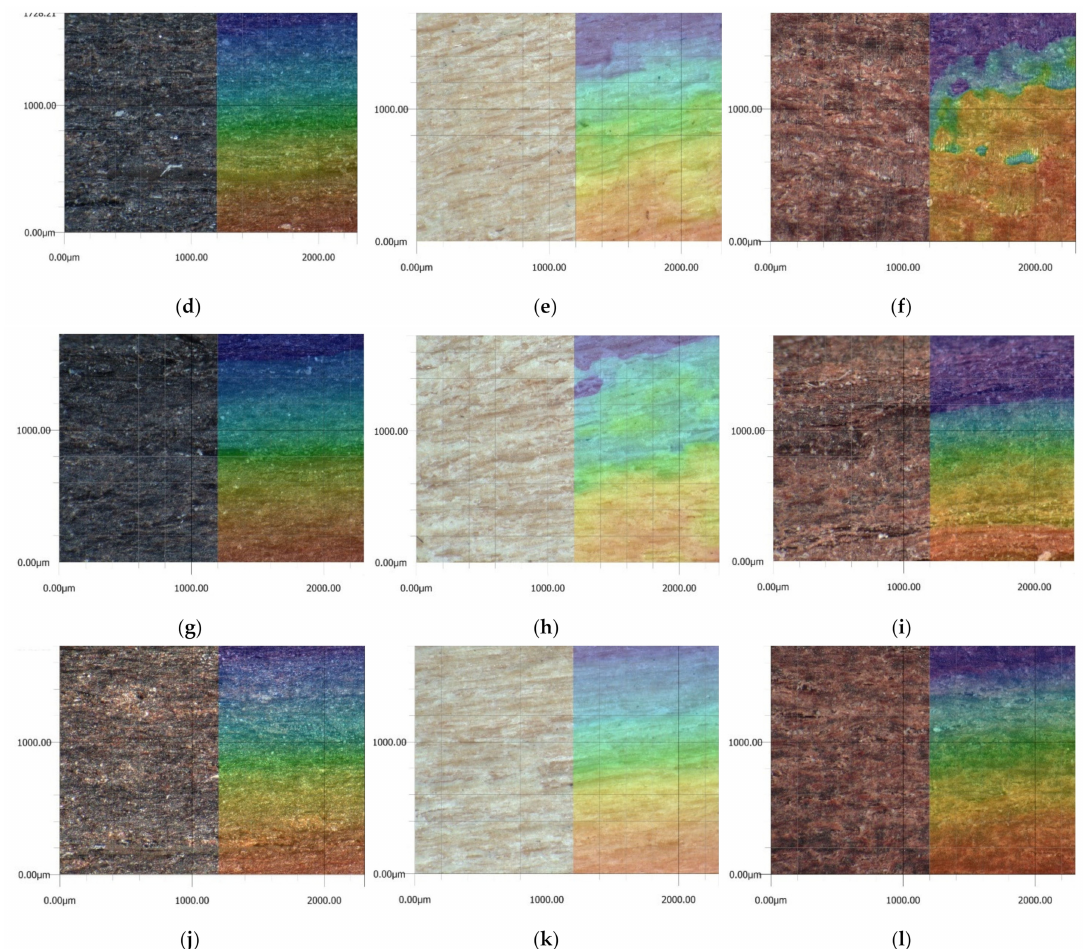
Figure 17. The macroscopic view of the surface after turning of a depth of 1.0 mm: ( a ) 3ER (TH) West African Ebony, ( b ) 3ER (TH) San Domingo Boxwood, ( c ) 3ER (TH) Rio Rosewood, ( d ) VBMT (PT) West African Ebony, ( e ) VBMT (PT) San Domingo Boxwood, ( f ) VBMT (PT) Rio Rosewood, ( g ) RCMX (RD) West African Ebony, ( h ) RCMX (RD) San Domingo Boxwood, ( i ) RCMX (RD) Rio Rosewood, ( j ) MGMN (GR) West African Ebony, ( k ) MGMN (GR) San Domingo Boxwood, and ( l ) MGMN (GR) Rio Rosewood.